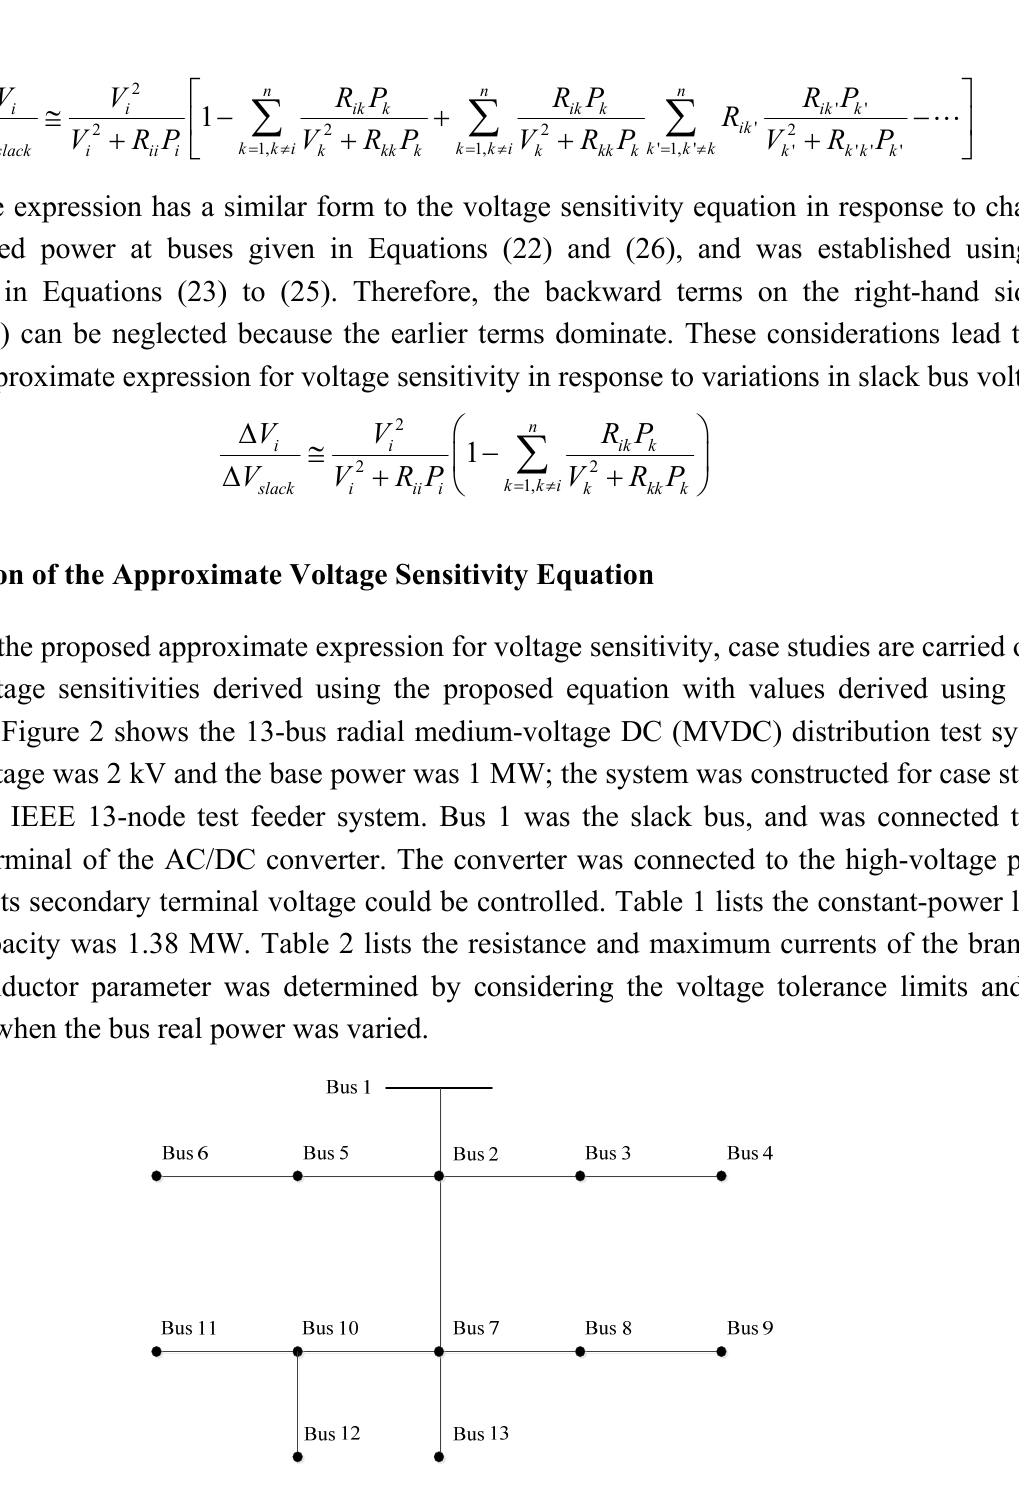
Figure 2. Diagram of a radial DC distribution